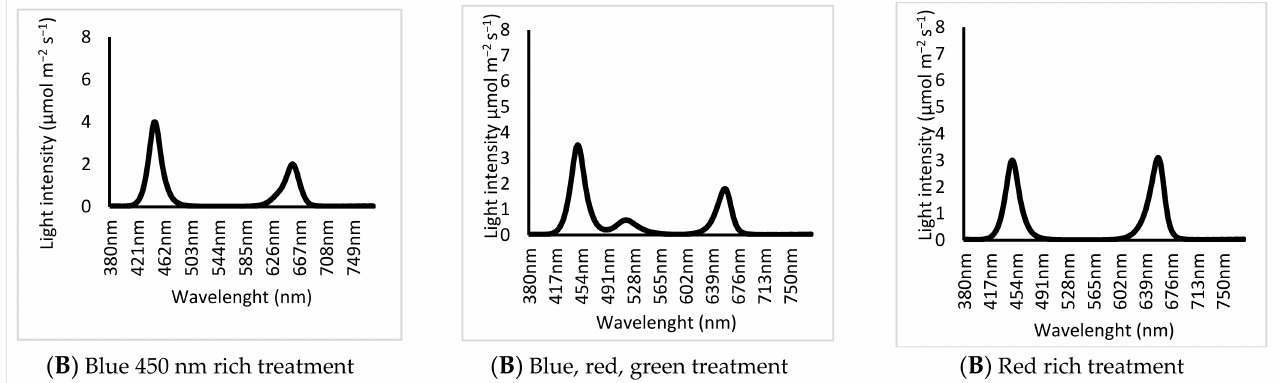
Figure 2. Spectra of the LED treatments (Blue/Red treatment (B-rich/R), blue, red, green treatment and red rich treatment) as measured by an UPRtek spectrophotometer: ( A ) the relative light intensity. ( B ) The radiant density of the light spectrum